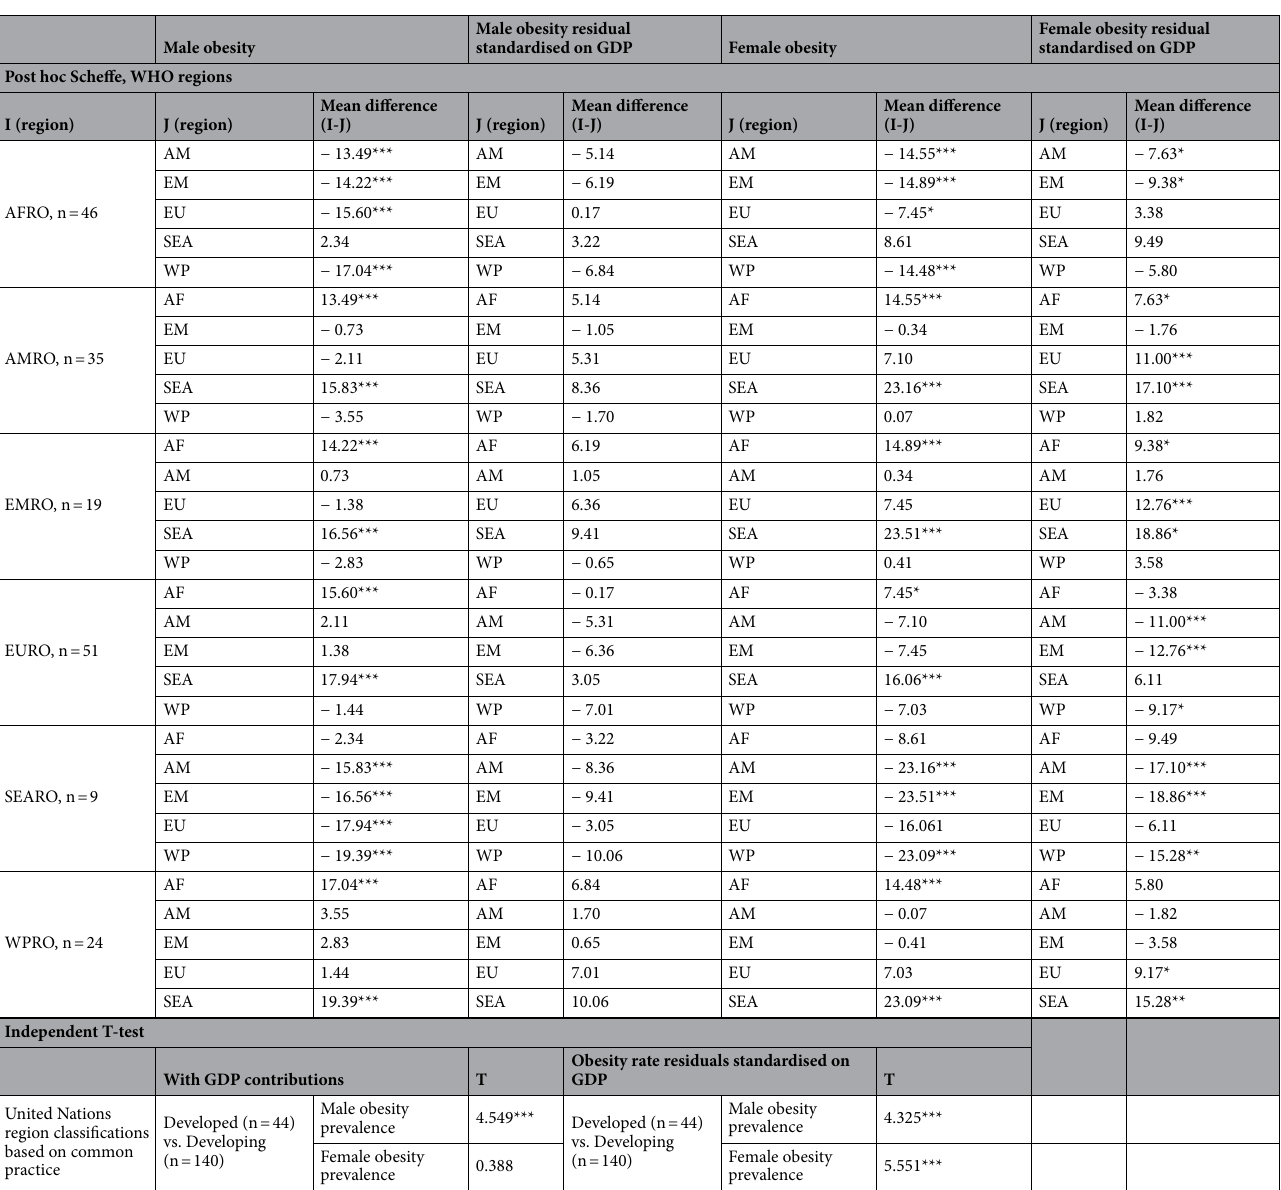
Table 5. Comparisons between sex-specific obesity prevalence rates between WHO regions, and between UN developed and developing regions. Data sources: Total calories data from the FAO’s FAOSTAT. BMI ≥ 30 prevalence (male and female) from the WHO Global Health Observatory; GDP per capita from the World Bank; Urbanization data from WHO; I bs from the previous publications. AF, Africa; AM, Americas; EM, Eastern Mediterranean; EU, Europe; SEA, South-East Asia; WP, Western Pacific; RO, Regional Office. *p < 0.05, **p < 0.01; ***p <